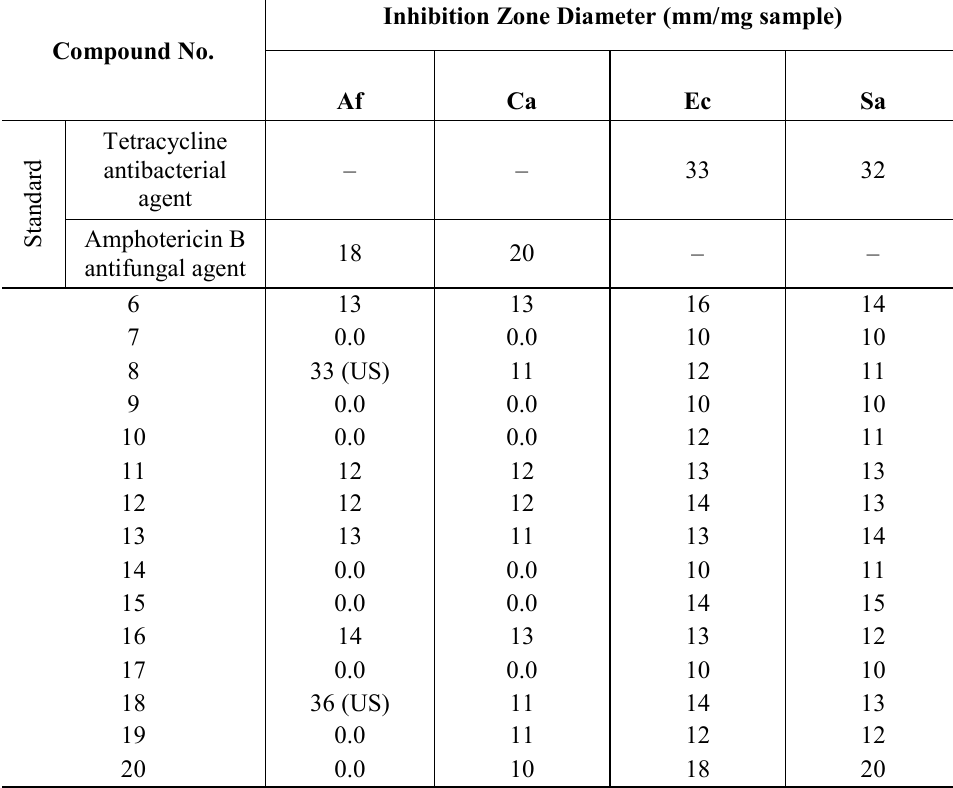
Table (2): Antifungal activity data and antibacterial activity.